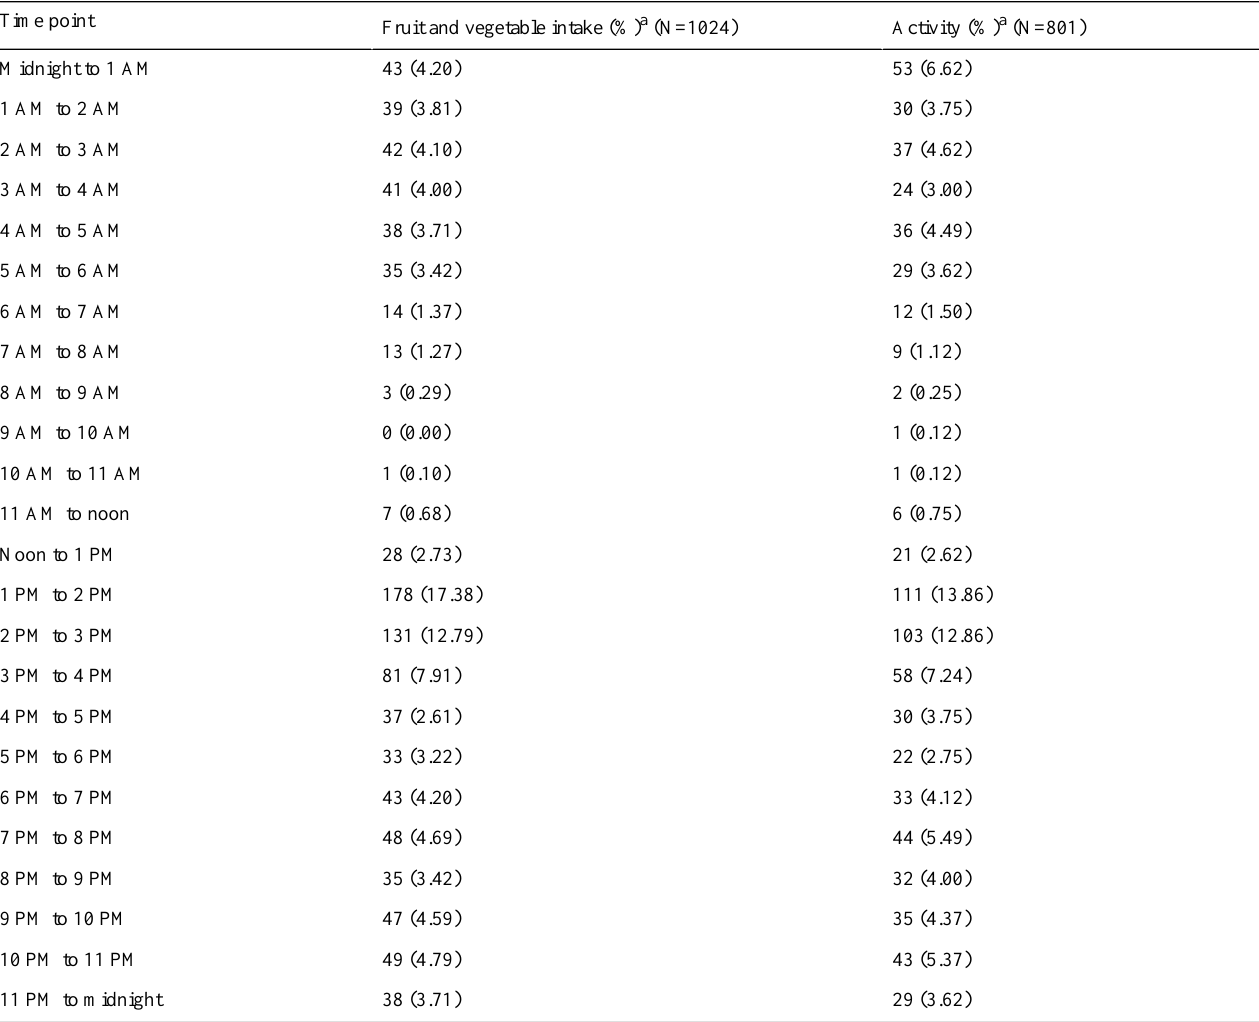
Table 5. Time of night data were recorded.